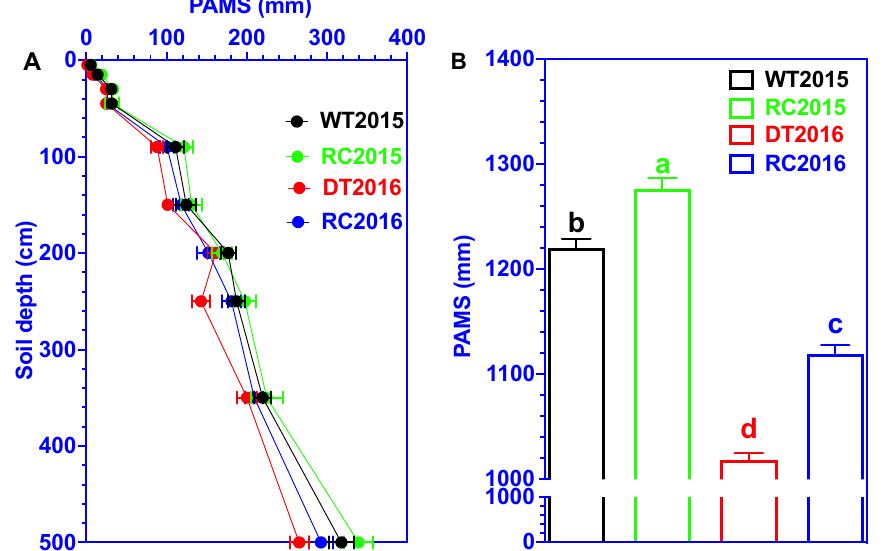
Figure 2. Vertical distribution (0–5 m, A ) and the content ( B ) of plant-available moisture storage (PAMS) in a wet year of higher-than-average rainfall (2015) and a dry year of lower-than-average rainfall (2016) in Robinia pseudoacacia forest stands of different treatments. WT2015 is wet year of 2015 without in situ rainwater collection and infiltration system; RC2015 is wet year of 2015 with in situ rainwater collection and infiltration system; DT2016 is dry year of 2016 without in situ rainwater collection and infiltration system and RC2016 is wet year of 2016 with in situ rainwater collection and infiltration system. Different letters indicate a statistically significant difference at p < 0.05 between treatments. Error bars represent ±1 SD.